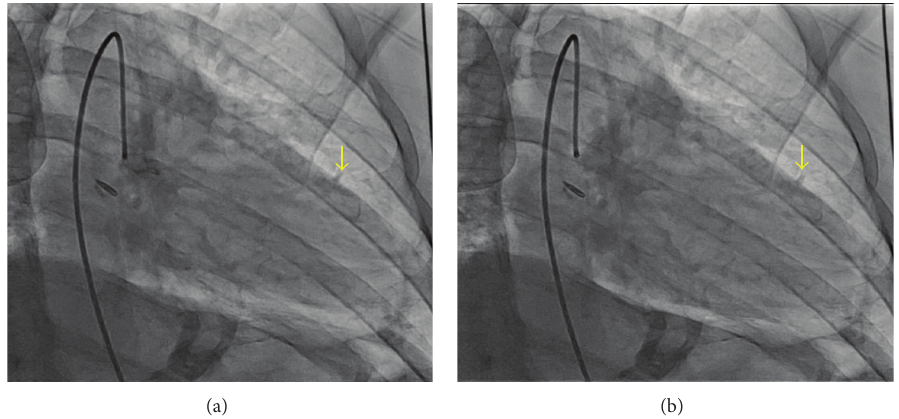
Figure 2: Left ventriculogram. Air around the cardiac borders noted in systole (a) and diastole (b).